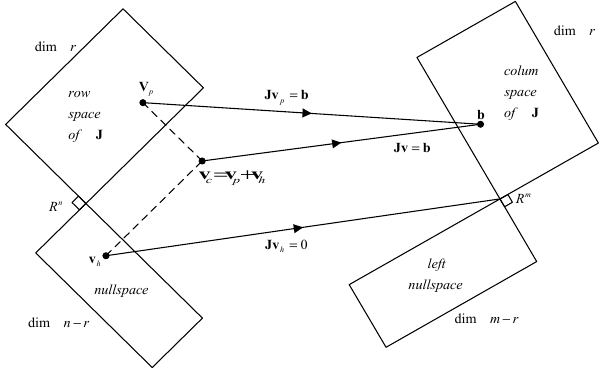
Figure 3. Orthogonal